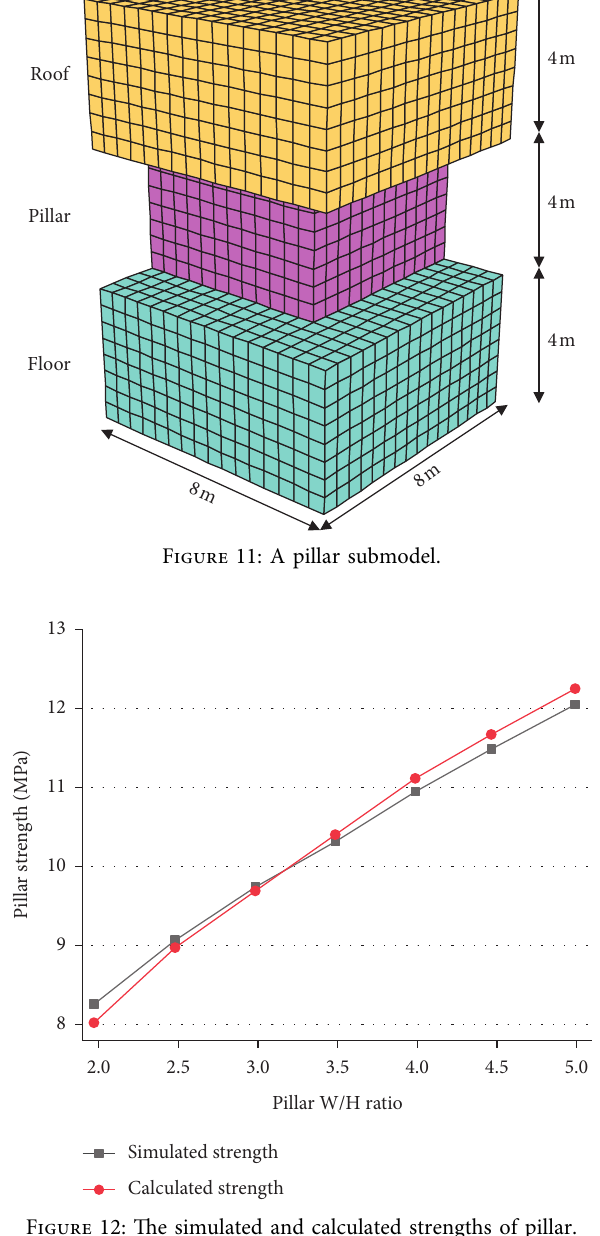
Figure 12: The simulated and calculated strengths of pillar.